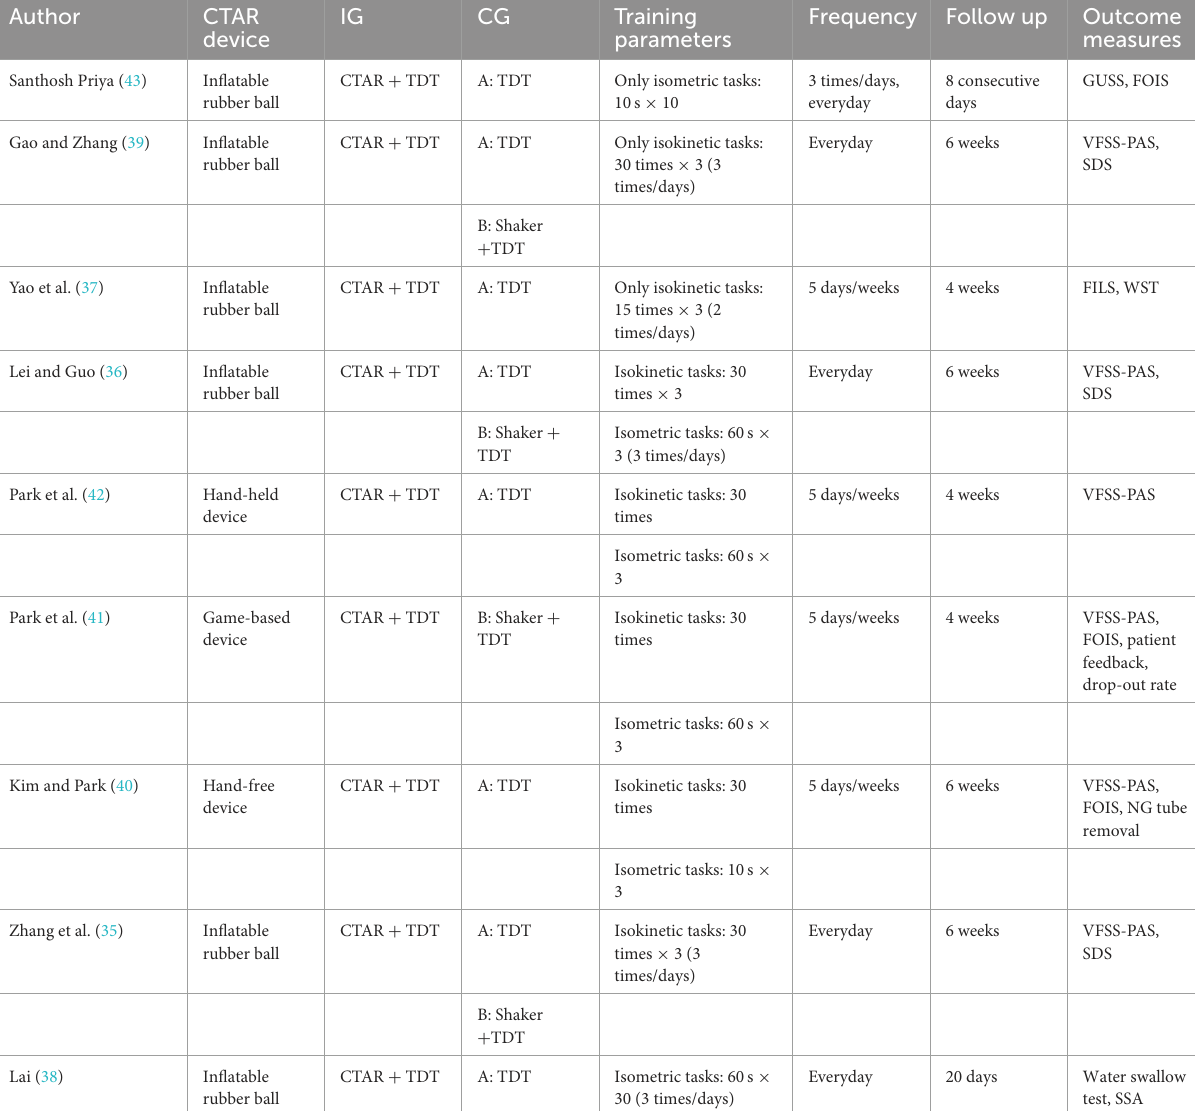
TABLE 2 Characteristics of intervention and control group in the included